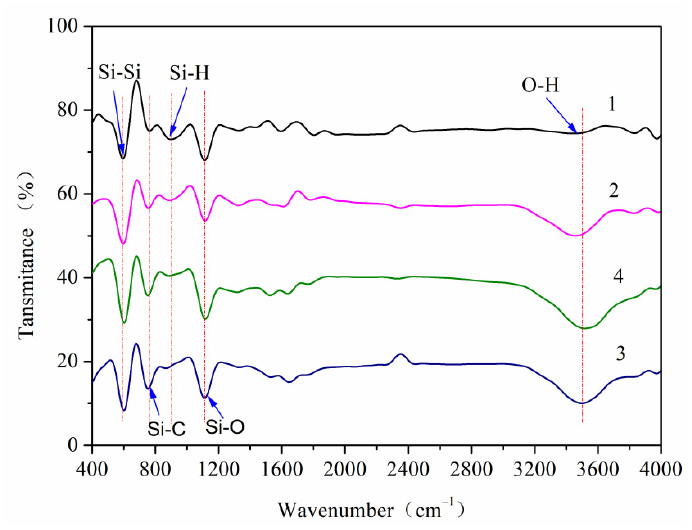
Figure 6. FTIR spectra of samples obtained by different O 2 plasma activation parameters.